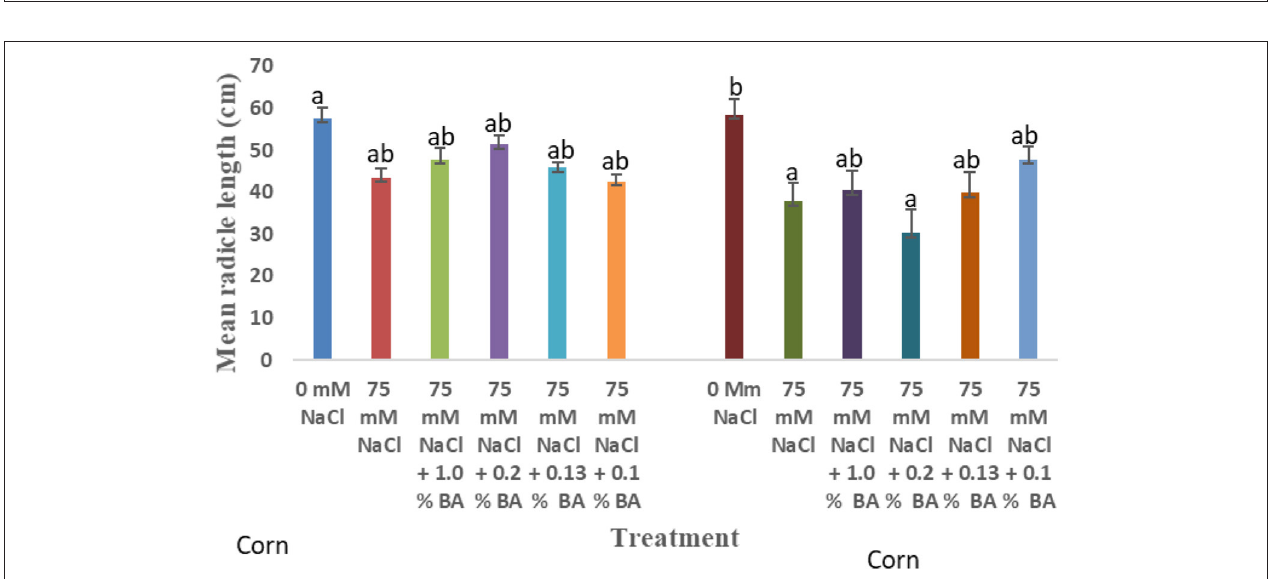
FIGURE 7 | Effect of BA cell-free supernatant on mean radicle length of corn and soybean exposed to 75mM NaCl. Treatments with similar letters are not significantly different. Treatments with different letters are significantly different.